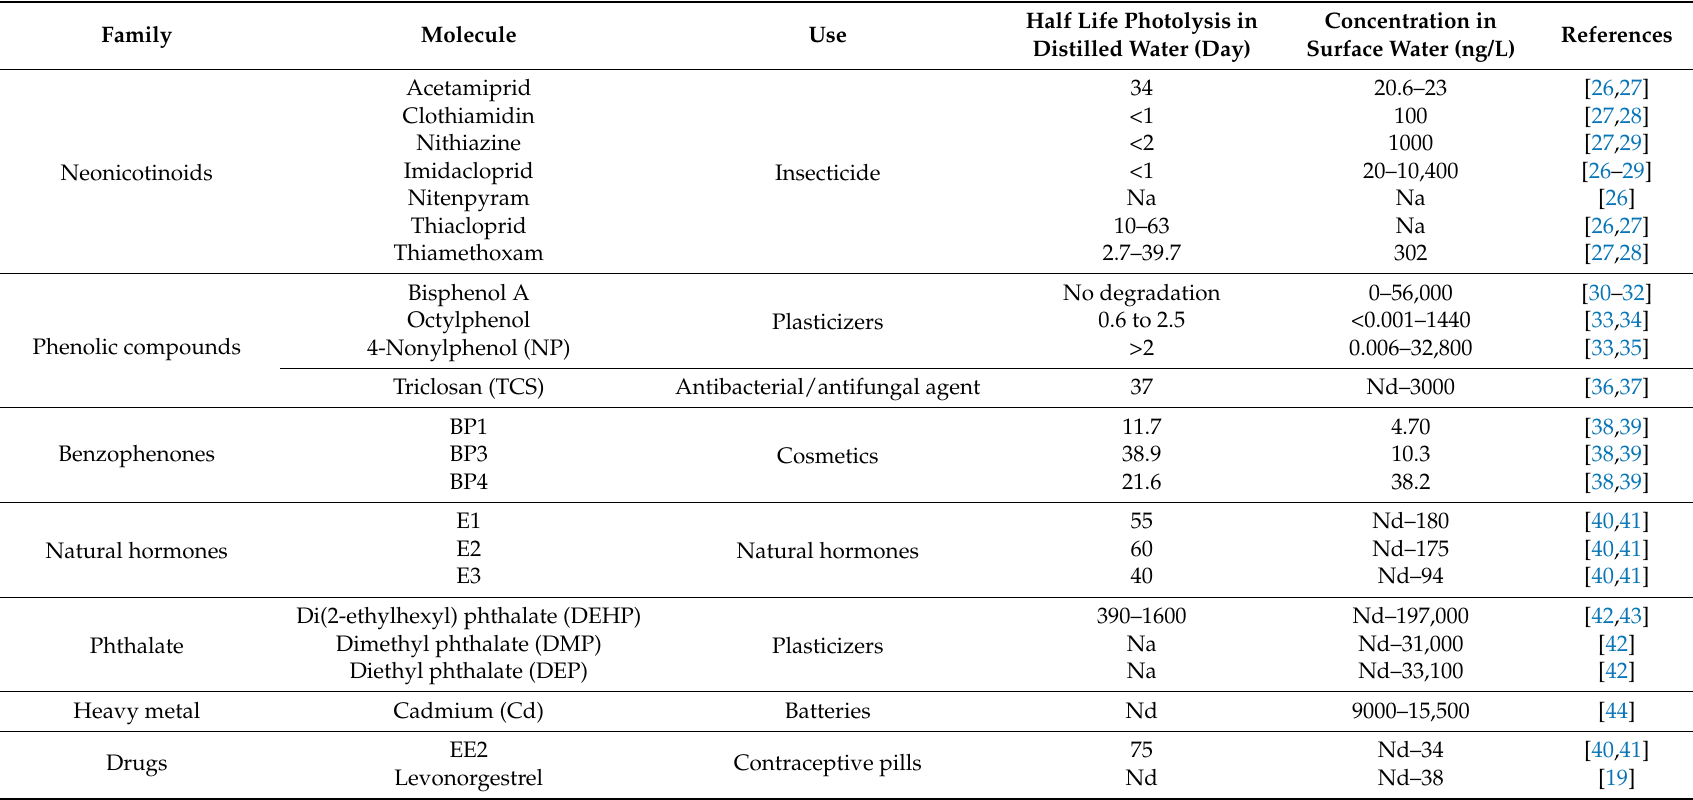
Table 1. Emerging endocrine-disrupting chemicals (EDCs) in water: description, half-life, and concentration.